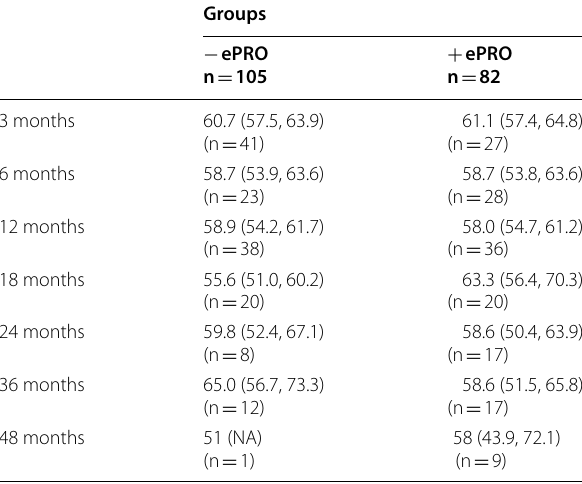
Table 2 Raw patient activation measurement (PAM) scores with 95% confidence intervals (CI) assessed after each follow-up consultation, i.e. 3, 6, 12, 18, 24, 36 and 48 months postoperatively. Each response is grouped according to the period with no electronic Patient-reported Outcomes ( and the period supported by electronic Patient-reported